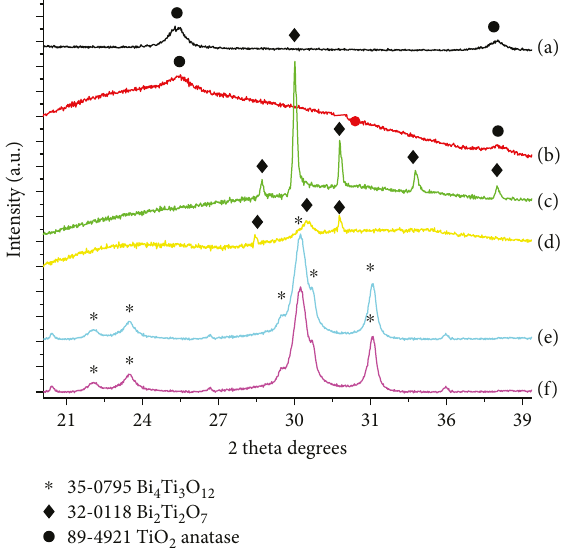
Figure 3: X-ray patterns of the TiO several bismuth contents (a) 0, (b) 0.5, (c) 4.9, (d) 10.4, (e) 21.5, and (f) 25.4at. %.